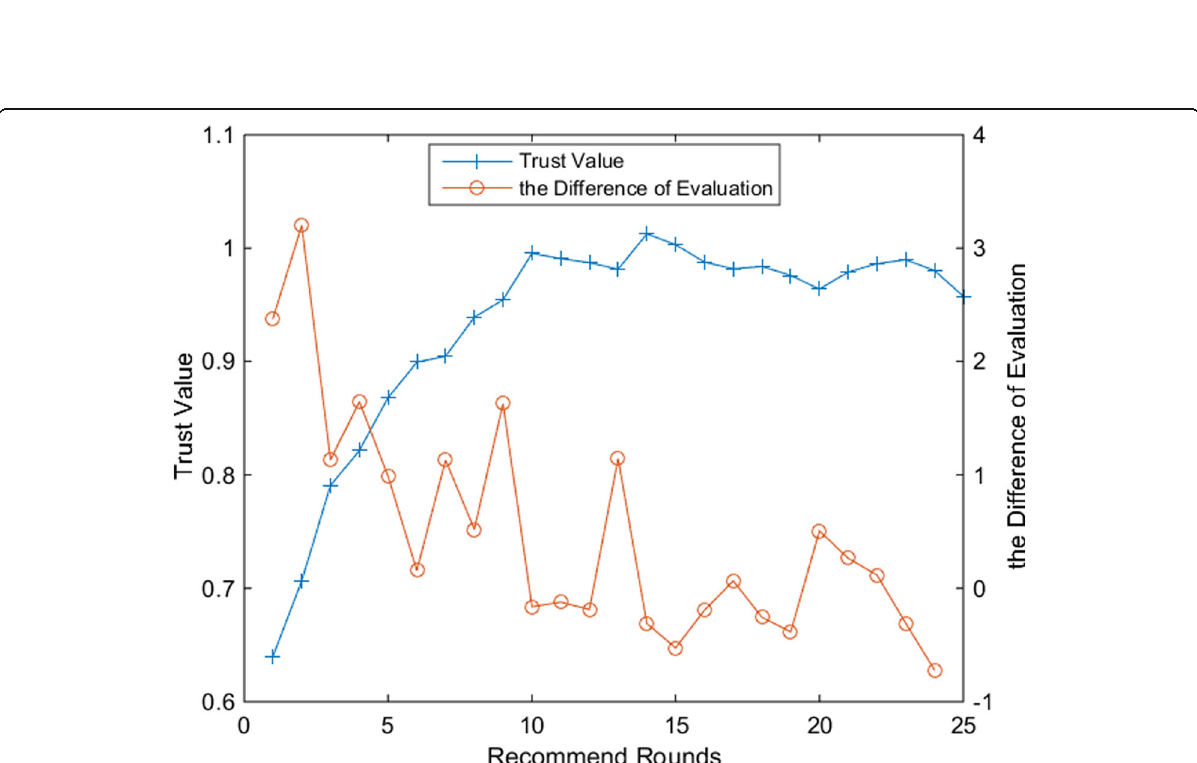
Fig. 10 Correlation graph of evaluation and trust (with LMS and η =